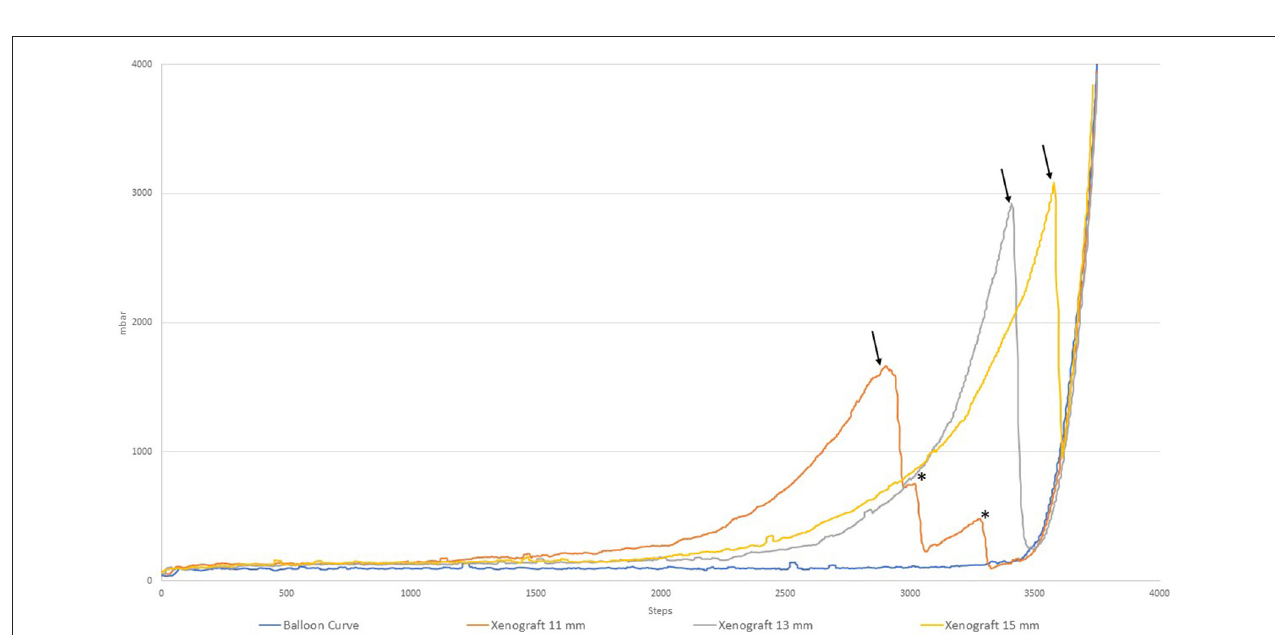
FIGURE 2 | Pressure-volume curves of different